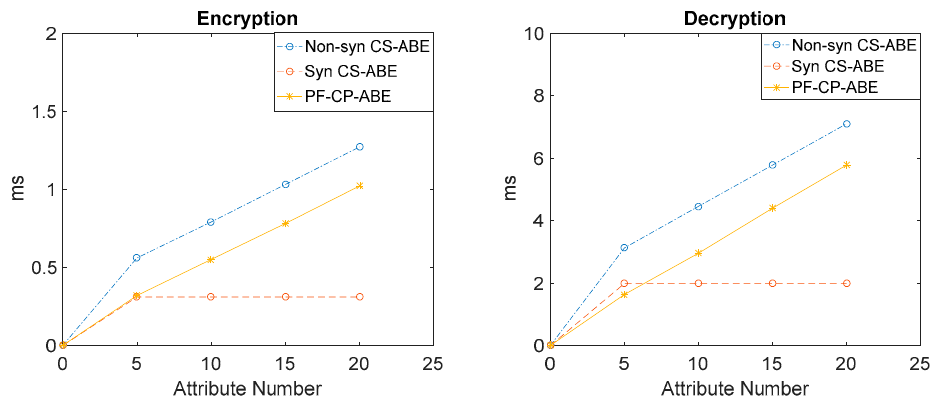
Figure 9. Comparisons of encryption and decryption times.